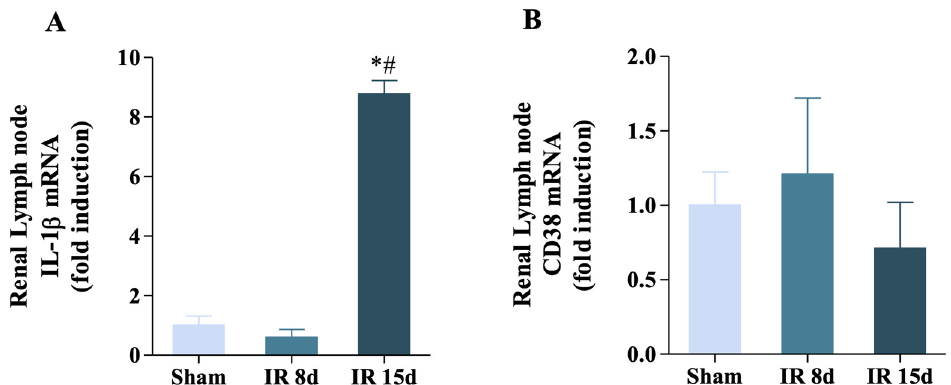
Figure 6. Renal ischemia/reperfusion was able to increase IL-1 β expression but not CD38 in the renal lymph node. ( A ) IL-1 β mRNA level and ( B ) CD38 mRNA level in the renal lymph node [Sham: n = 5, IR 8d: n = 4, IR 15d: n = 3]. Data are expressed as mean ± SEM, and one-way ANOVA followed by Bonferroni’s post hoc test were performed. * vs. sham p < 0.05; # vs. IR 8 days p < 0.05.